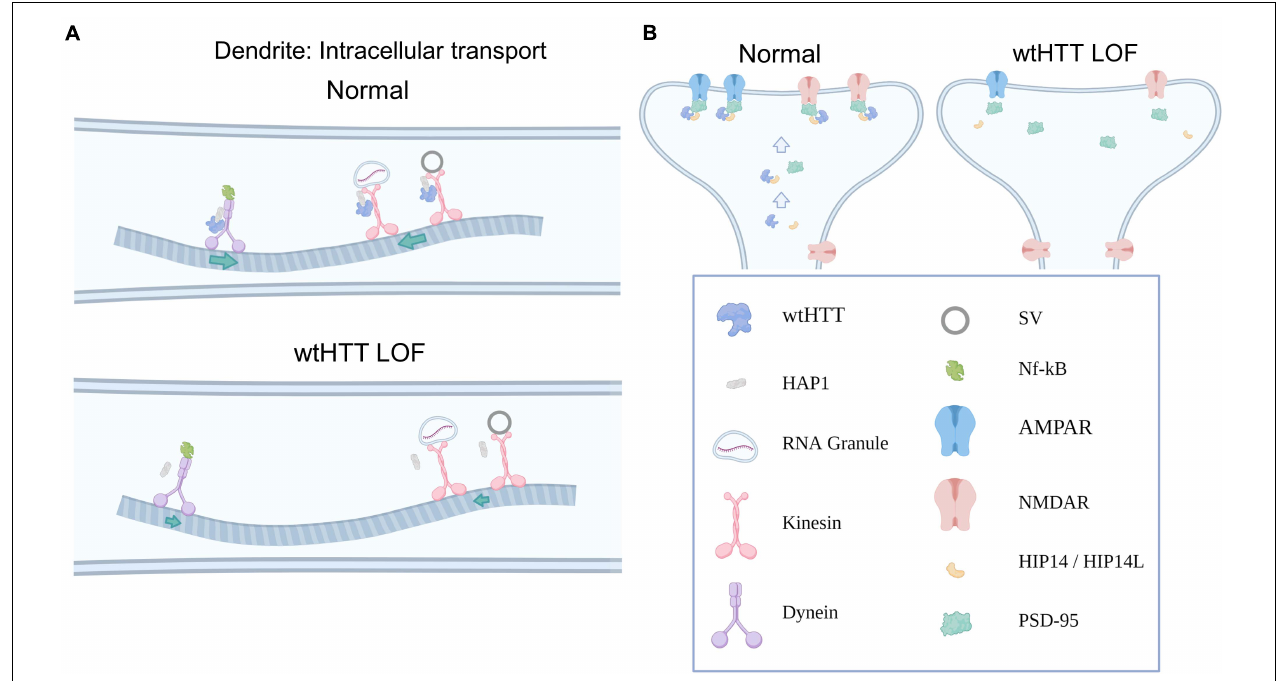
FIGURE 2 | Huntingtin and the postsynapse. (A) Select examples demonstrating how wtHTT positively regulates dendritic transport (top). Through its associations with HAP1, as well as molecular motors, wtHTT regulates anterograde and retrograde transport of synaptic receptors and other cargo in dendrites (left). wtHTT LOF disrupts this transport and slows delivery of synaptic cargo to their respective anterograde or retrograde targets (bottom). (B) Select examples demonstrating how wtHTT positively regulates receptor localization (left). Through its associations with HIP14 and PSD-95, wtHTT regulates synaptic receptor stabilization at the PSD in a healthy postsynaptic neuron. wtHTT LOF disrupts postsynaptic protein clustering and receptor localization (right). Abbreviations: LOF, loss of function; HAP1, huntingtin-associated protein 1; SV, synaptic vesicle; NF- κ B, nuclear factor kappa B; AMPAR, α -Amino-3-hydroxy-5-methyl-4-isoxazolepropionic acid receptor; NMDAR, N-Methyl-D-aspartate receptor; HIP14/HIP14L, huntingtin-interacting protein 14/huntingtin-interacting protein 14-like; PSD-95, postsynaptic density protein 95. Figure created using